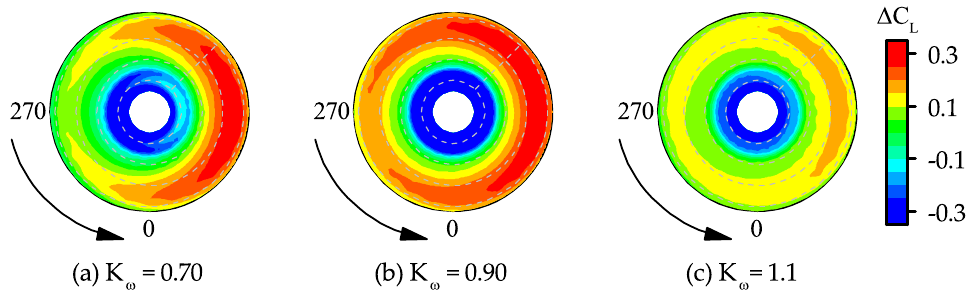
Figure 12. During hover, lift coefficient, C L , with rotor speed.